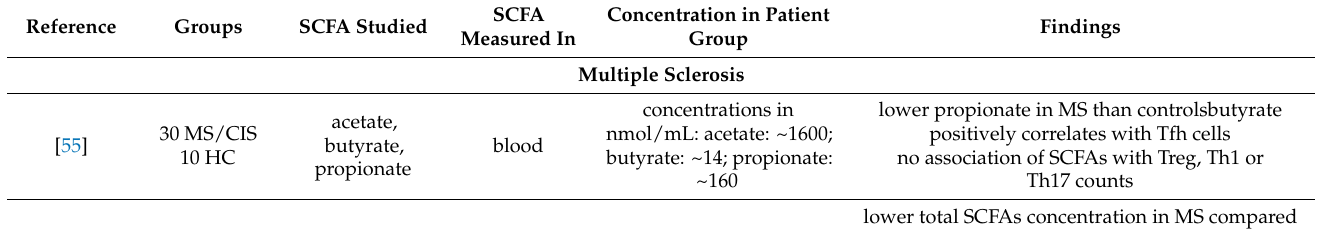
Table 3. Association studies of SCFA and in humans with autoimmune